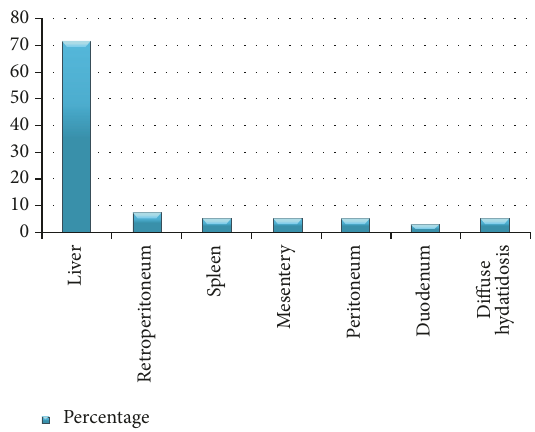
Figure 1: Intraoperative findings of cyst distribution by site.